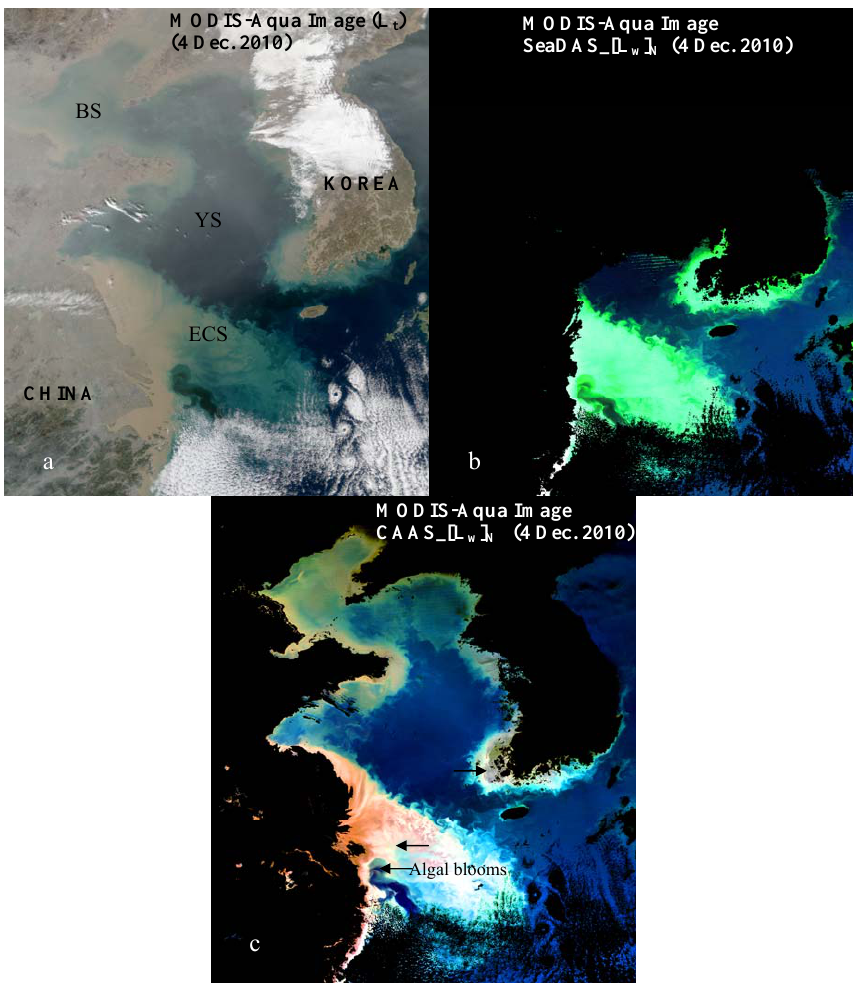
Fig. 3. MODIS-Aqua true colour composite image (4 December 2010) for the East China Sea (ECS), Yellow Sea (YS), Bogai Sea (BS) and waters around Korea generated from the total radiances at 443, 551 and 488nm (B253) (a) and the corresponding water-leaving radiances from the SeaDAS algorithm (b) and CAAS algorithm (c)